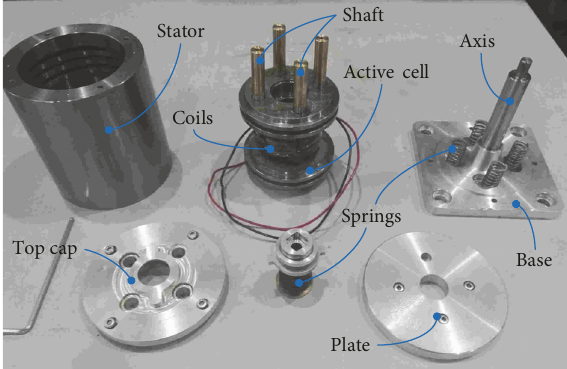
Figure 7: Photograph of the components of the EVI.